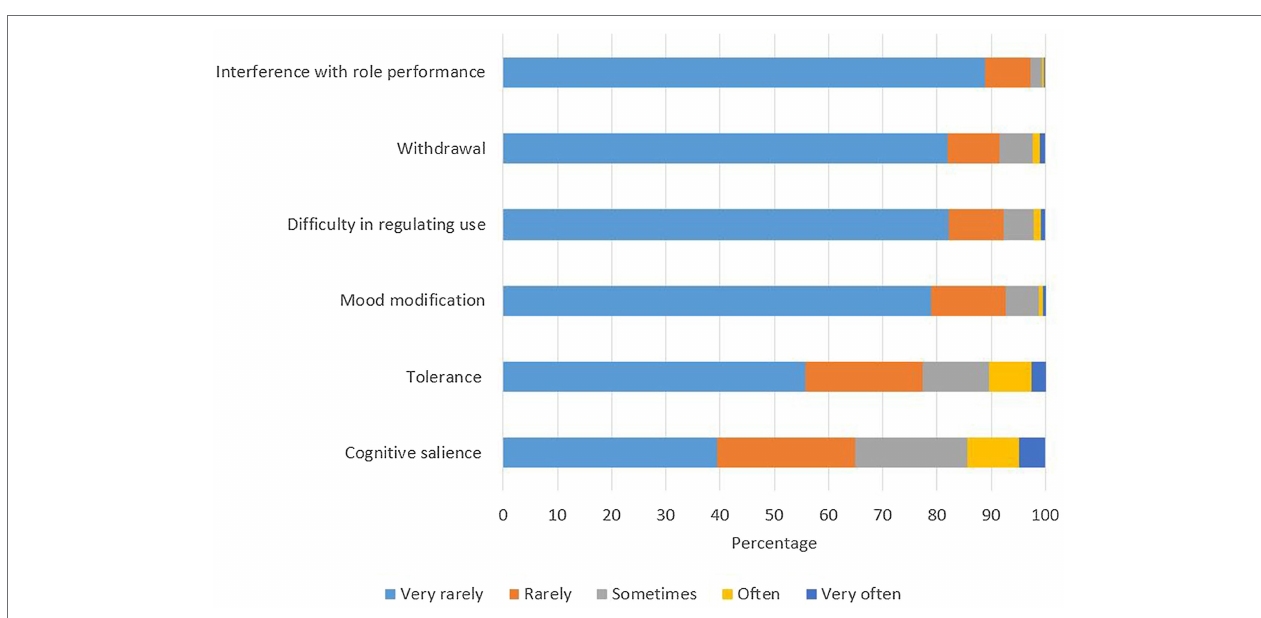
FIGURE 3 | Endorsement rate of each item of social media addiction scale among social media users ( n = 658).